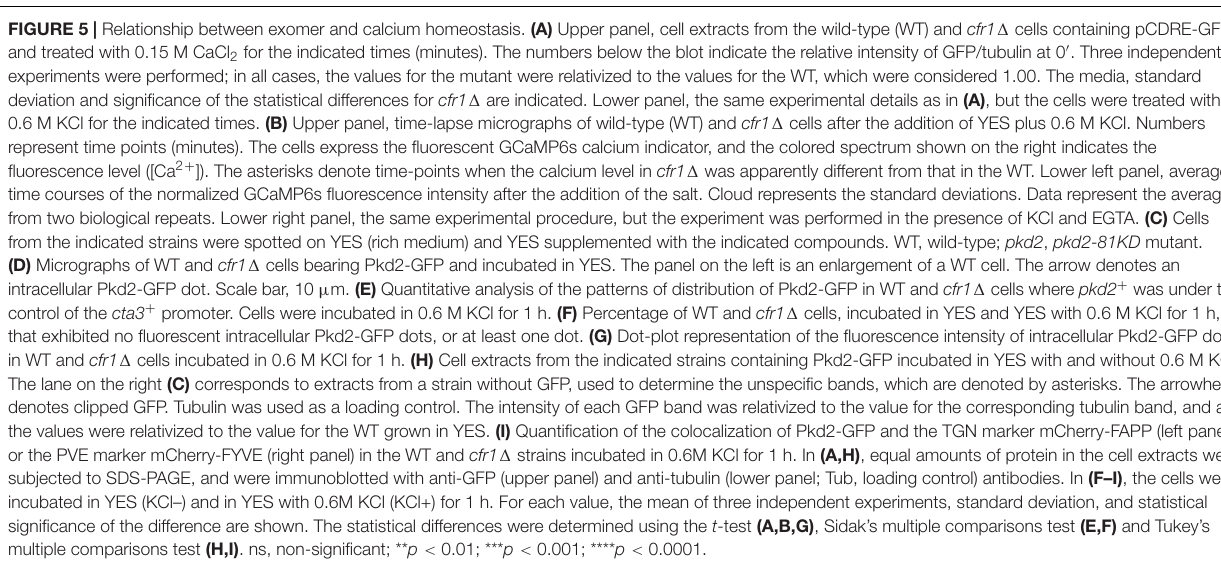
FIGURE 5 | Relationship between exomer and calcium homeostasis. (A) Upper panel, cell extracts from the wild-type (WT) and cfr1 (cid:49) cells containing pCDRE-GFP and treated with 0.15 M CaCl 2 for the indicated times (minutes). The numbers below the blot indicate the relative intensity of GFP/tubulin at 0 (cid:48) . Three independent experiments were performed; in all cases, the values for the mutant were relativized to the values for the WT, which were considered 1.00. The media, standard deviation and significance of the statistical differences for cfr1 (cid:49) are indicated. Lower panel, the same experimental details as in (A) , but the cells were treated with 0.6 M KCl for the indicated times. (B) Upper panel, time-lapse micrographs of wild-type (WT) and cfr1 (cid:49) cells after the addition of YES plus 0.6 M KCl. Numbers represent time points (minutes). The cells express the fluorescent GCaMP6s calcium indicator, and the colored spectrum shown on the right indicates the fluorescence level ([Ca 2 + ]). The asterisks denote time-points when the calcium level in cfr1 (cid:49) was apparently different from that in the WT. Lower left panel, average time courses of the normalized GCaMP6s fluorescence intensity after the addition of the salt. Cloud represents the standard deviations. Data represent the average from two biological repeats. Lower right panel, the same experimental procedure, but the experiment was performed in the presence of KCl and EGTA. (C) Cells from the indicated strains were spotted on YES (rich medium) and YES supplemented with the indicated compounds. WT, wild-type; pkd2 , pkd2-81KD mutant. (D) Micrographs of WT and cfr1 (cid:49) cells bearing Pkd2-GFP and incubated in YES. The panel on the left is an enlargement of a WT cell. The arrow denotes an intracellular Pkd2-GFP dot. Scale bar, 10 µ m. (E) Quantitative analysis of the patterns of distribution of Pkd2-GFP in WT and cfr1 (cid:49) cells where pkd2 + was under